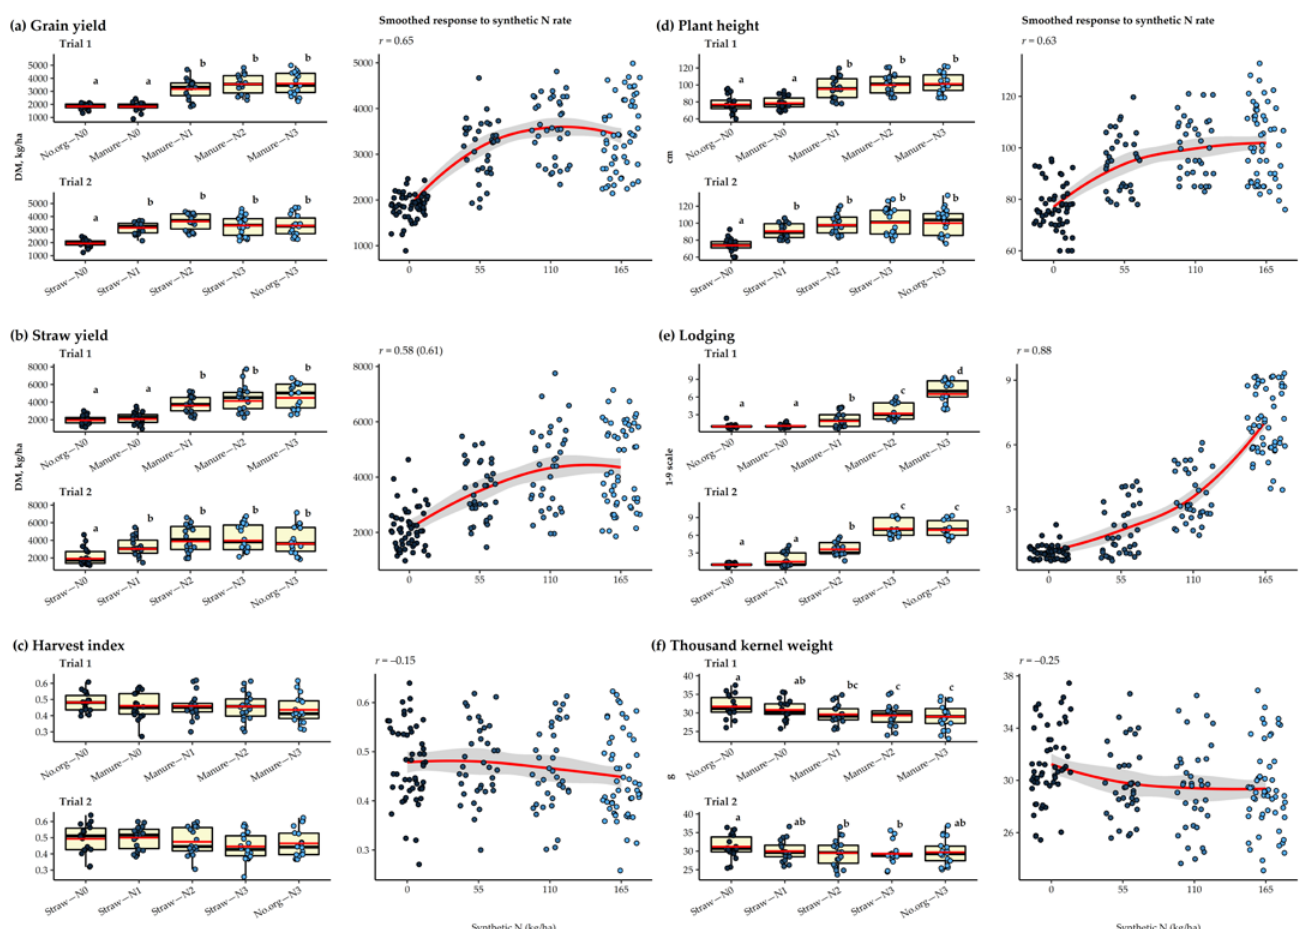
Figure 1. The response of oat agronomic performance traits ( a – f ) to different N rates and agronomic management practices applied in a long-term field experiment during 2015–2020. The red crossbar in the boxplot indicates the mean, while the dots represent individual observations. Means marked with different letters represent significant differences within each trial according to Tukey’s HSD test ( α = 0.05). The smoothed conditional means method (Loes method) represents the overall observed response of the selected variables to the synthetic N rate and the correlation coefficient. When the data was transformed in both trials, the “ r ” value in brackets indicates the correlation coefficient for the transformed data.